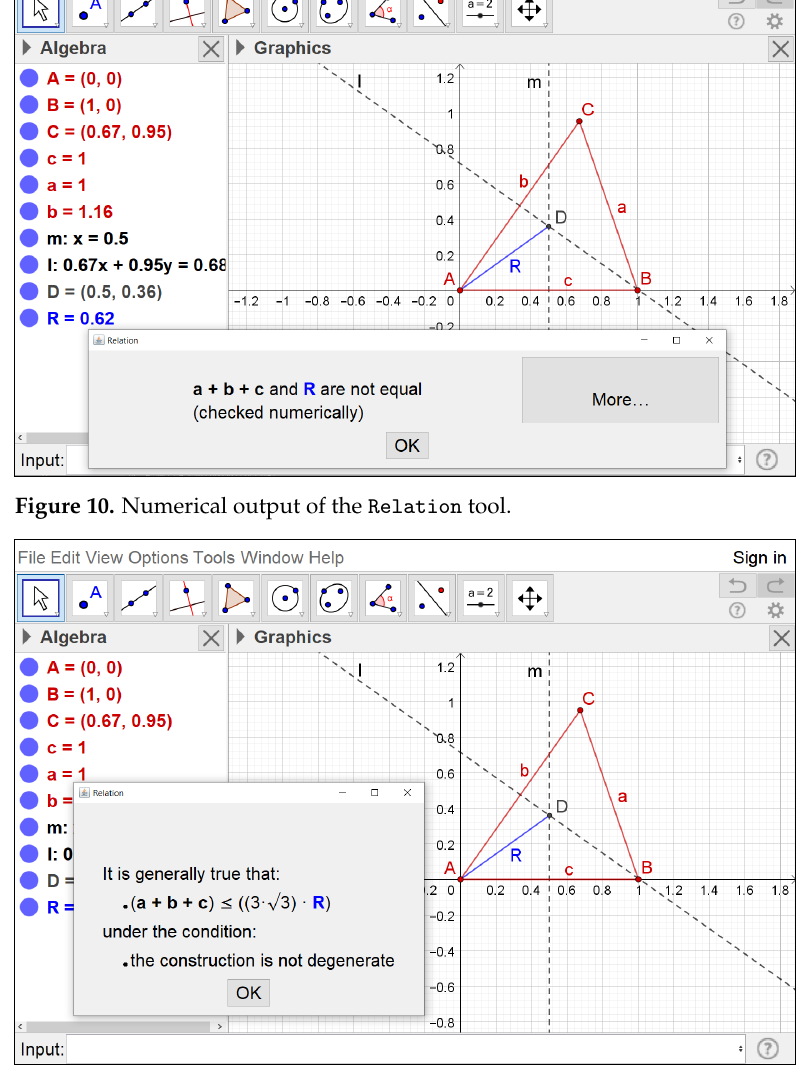
Figure 11. Symbolic output of the Relation